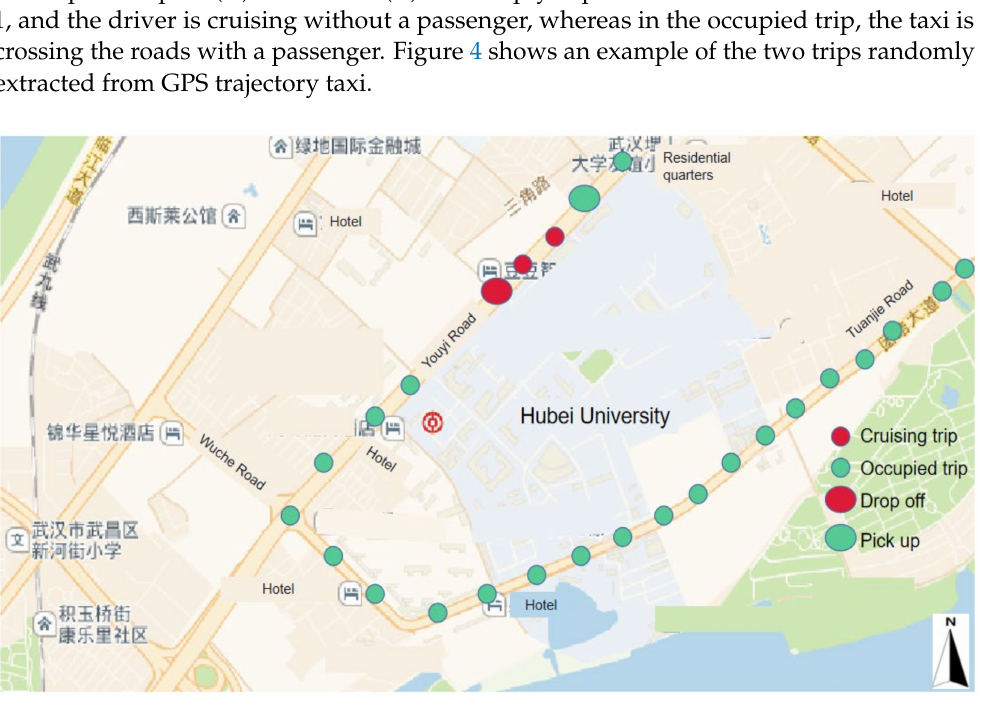
Figure 4. An example of the two trips randomly extracted from a GPS taxi trajectory. The occupied trip crossed Tuanjie road and ends at the gate of Hubei university and dropped off the passenger, and after several meters another passenger is picked up and anther occupied trip